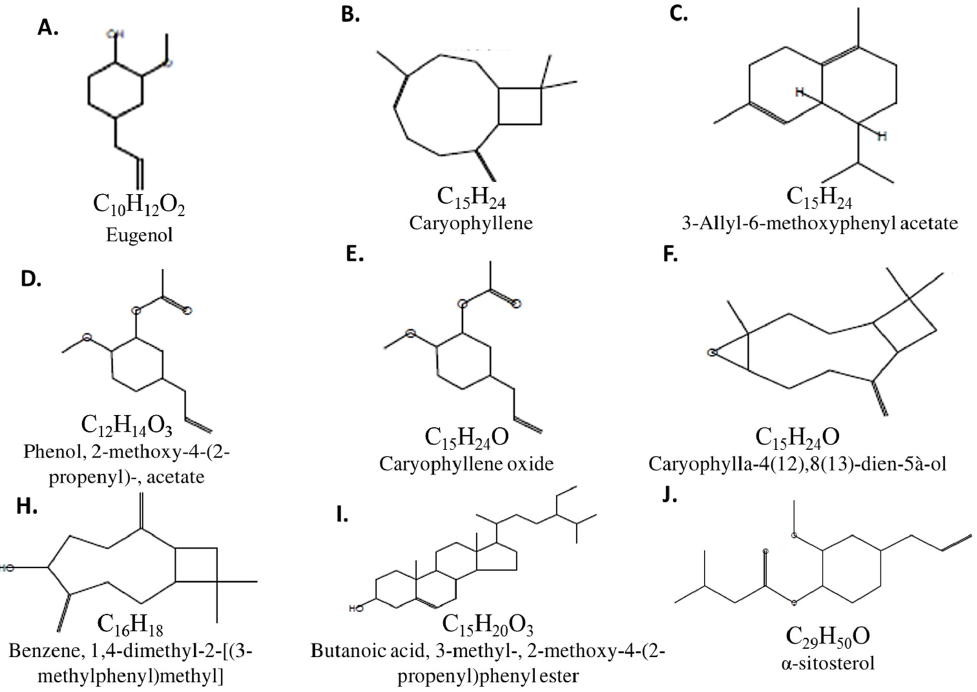
Figure 1. Chemical structure of the GC-MASS-screened Syzygium aromaticum ethanolic extract bioactive compounds ( A – J ). (Figure 3). 2.3. Validation of Type 1 Diabetic and Diabetic Wound Onset The results of the present investigation illustrated that the streptozotocin (STZ), in- traperitoneally injected in rats, lead to the development of both sustained elevations in blood glucose level ≥ 500 mg/dL and a sharp decrease in serum insulin level <3.5 mIU/mL (Figure 2A,B) with a progressive decrease in body weight within the first 3 weeks of dia- betic induction. This was correlated with a clear manifestation of polydipsia, polyuria, monitored with water intake and little moisture content, and polyphagia, monitored with daily feed intake of the rats investigated. Moreover, three days post diabetic wound cura- tion and infection with P. mirabilis , the wound showed signs of suppuration and local